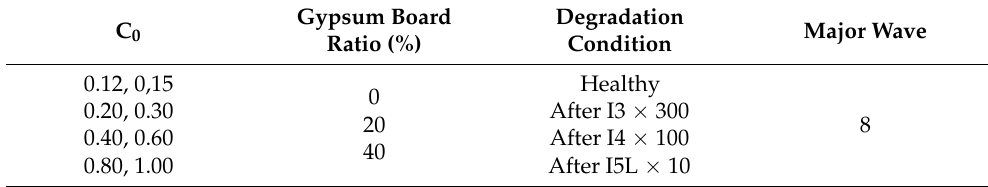
Table 4. Parameter of analysis.